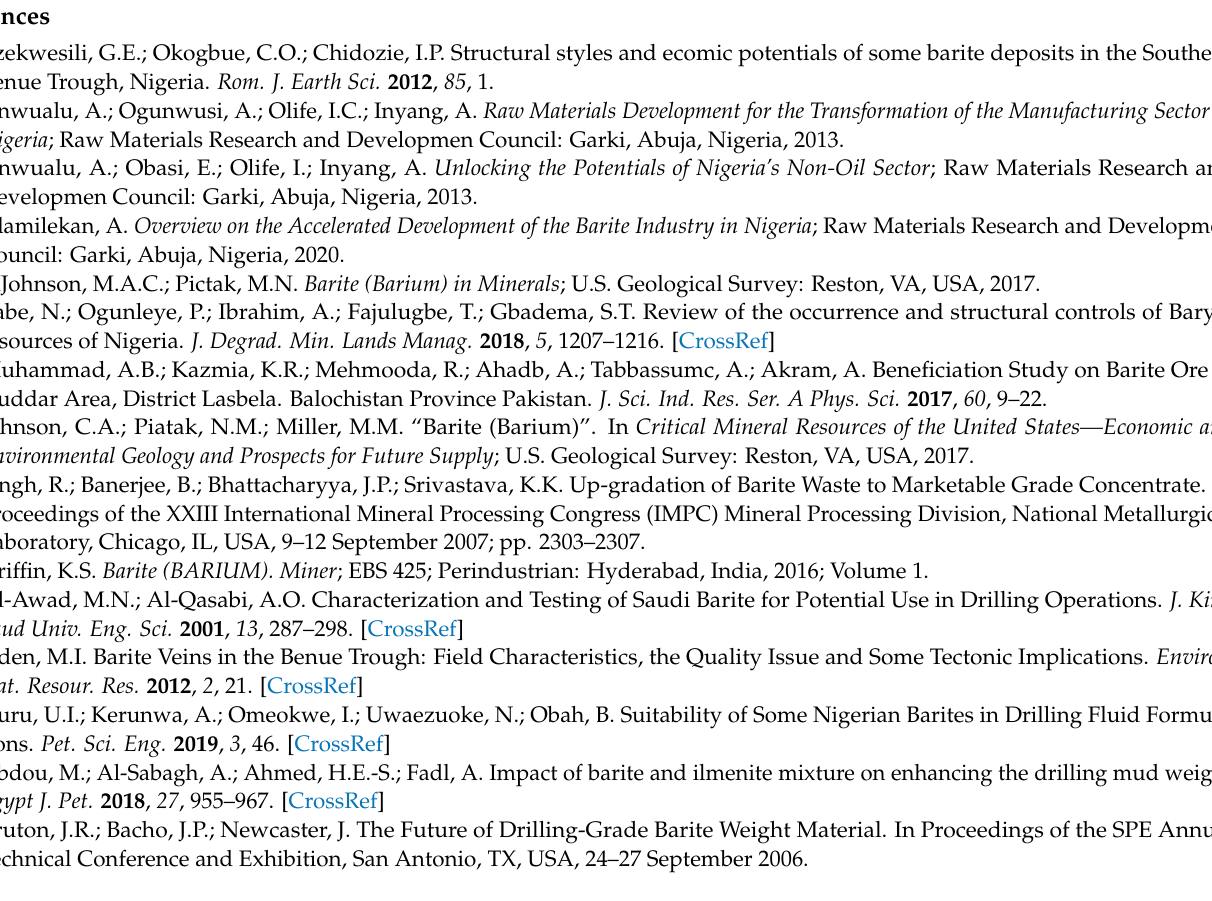
Figure S2: FTIR Spectra for the barite samples from different mining sites, Figure S3: XRF spectra for barite samples from AZARA VEIN 1, Figure S4: XRF spectra for barite samples from AZARA VEIN 17, Figure S5: XRF spectra for barite samples from AZARA VEIN 18, Figure S6: XRF spectra for barite samples from KEANA, Figure S7: XRF spectra for barite samples from KUMAR, Figure S8: XRF spectra for barite samples from RIBI, Figure S9: XRF spectra for barite samples from SAUNI, Figure S10: XRF spectra for barite samples from WUSE, Table S1: The physical appearance of the samples, Table S2: Mine site location in the Local Government